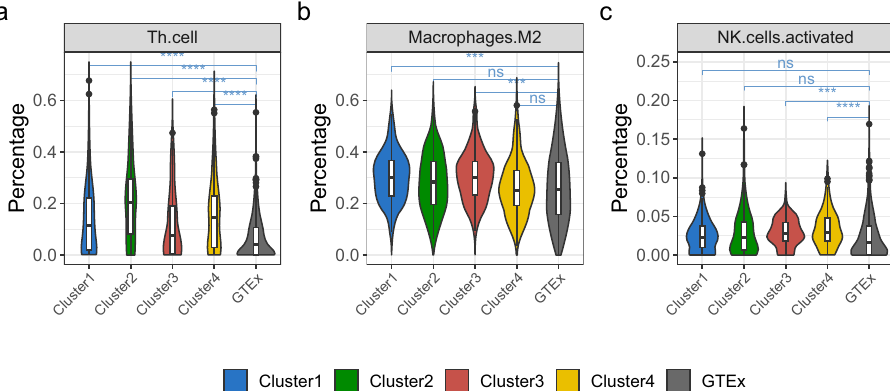
Fig. 7 Comparison of Th cell, M2, and activated NK cell between four clusters and GTEx. The differences between groups were measured by the Kruskal Wallis test. * Indicates P -value < 0.05, ** Indicates P -value < 0.01, *** Indicates P -value < 0.001, **** Indicates P -value <